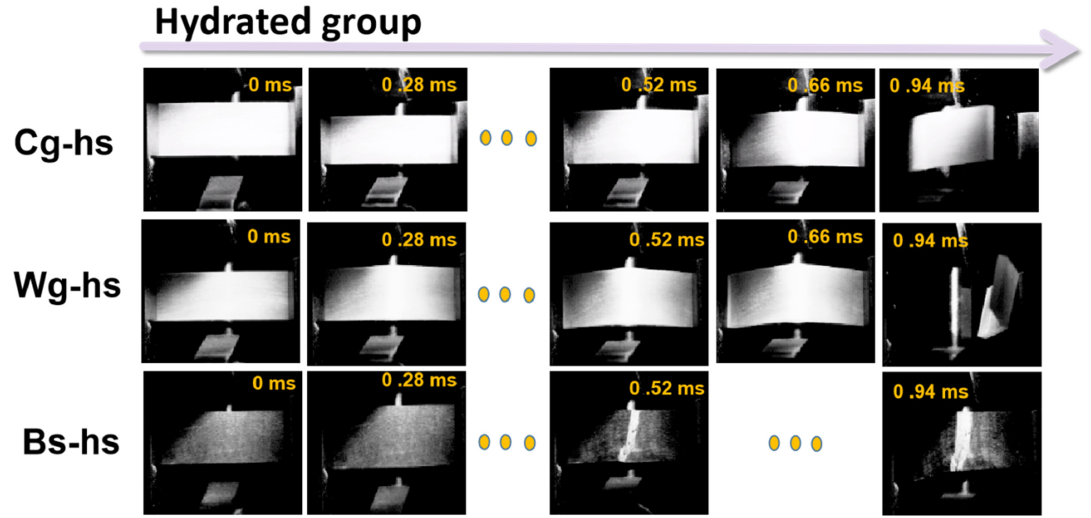
Figure 6. High ‐ speed camera images of impact process for the three Caprinae horn sheaths (Hydrated group).